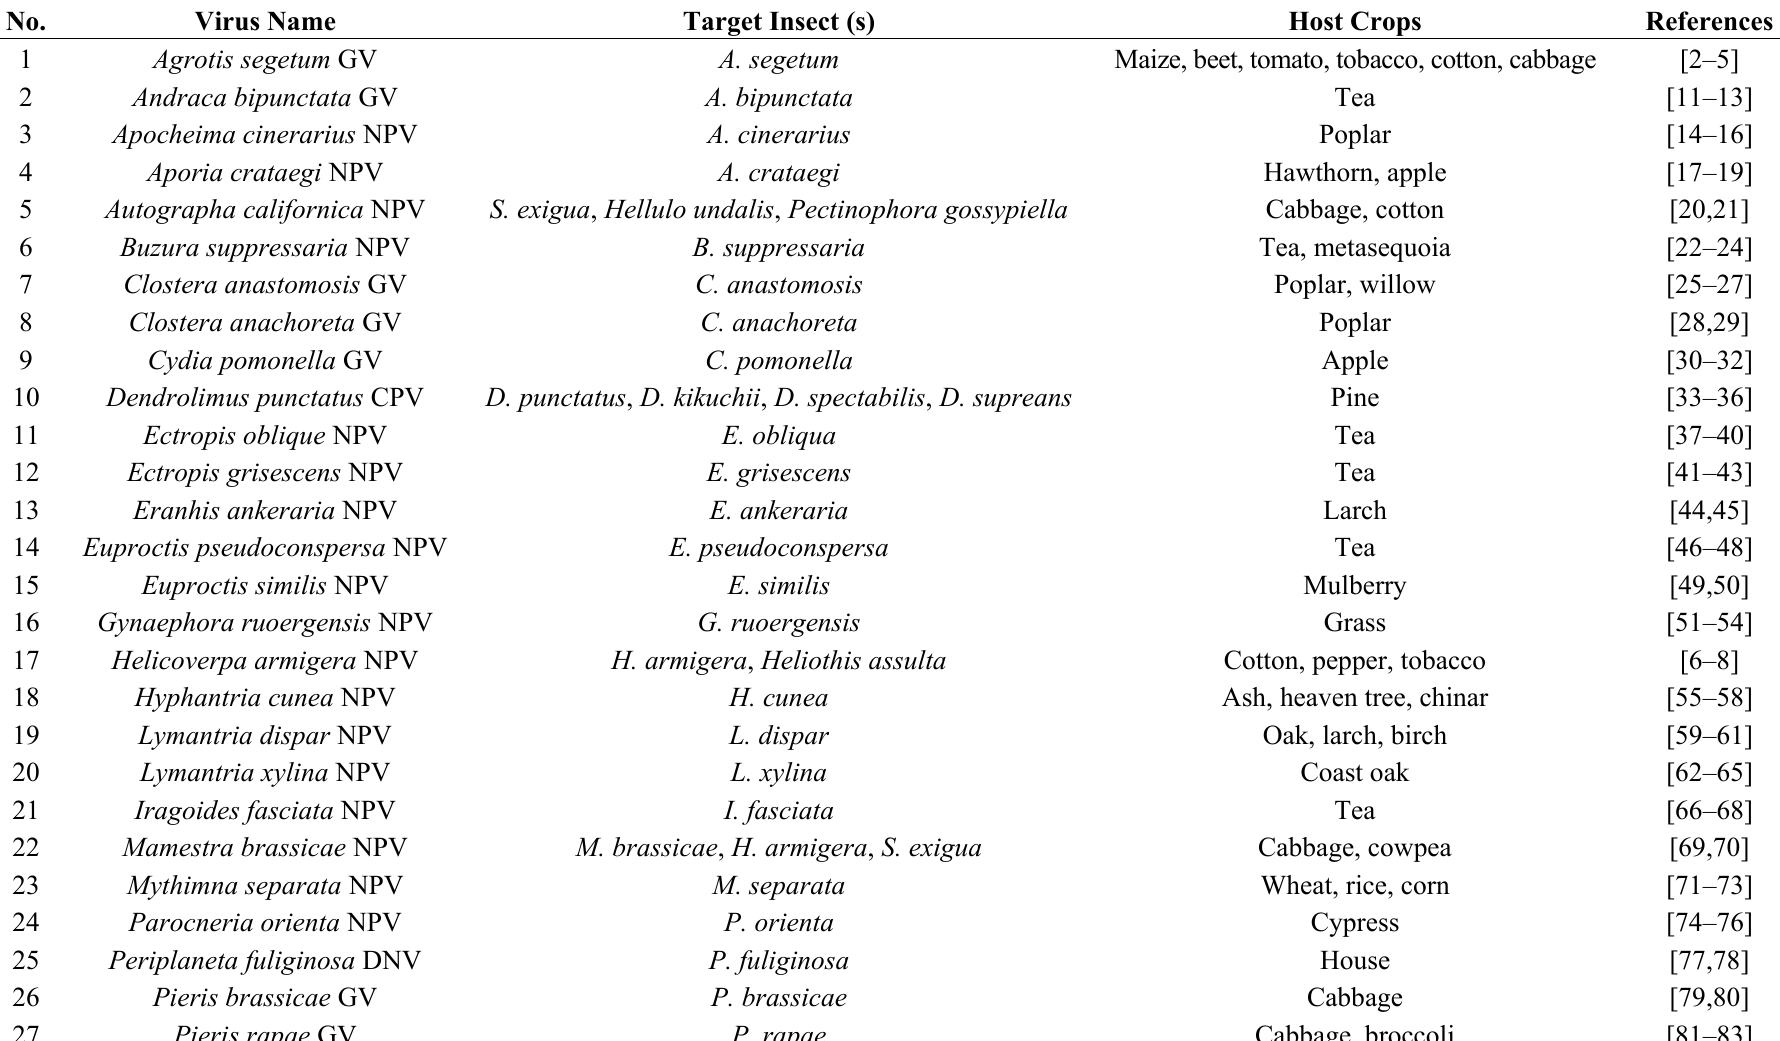
Table 1. Insect viruses evaluated as potential bioinsecticides in